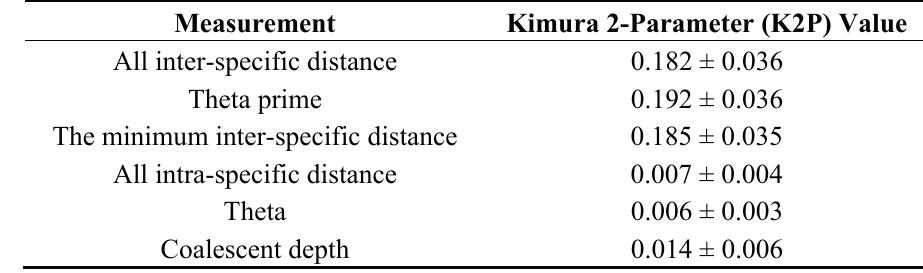
Table 1. Analyses of inter-specific divergence and intra-specific variation of the ITS2 (Internal transcribed spacer 2) sequences in 364 samples of 64 Dendrobium